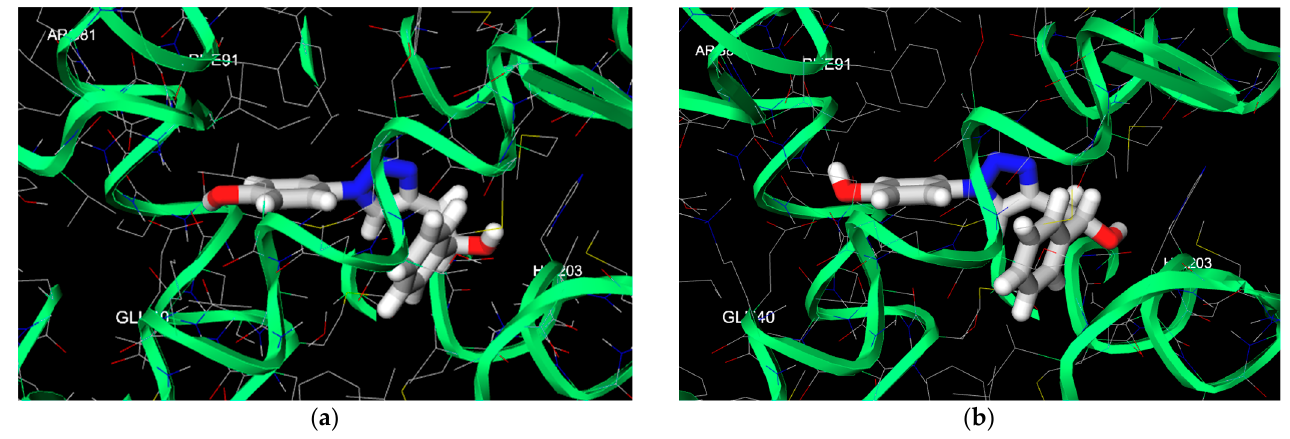
Figure 3. Docked structures of 1-(4-hydroxyphenyl)- α -phenyl-1,2,3-triazole-4-ethanol ( 21 ) in the binding pocket of agonist mode human ER β (pdb code 2jj3): ( a ) (R) stereoisomer; ( b ) (S) stereoisomer.